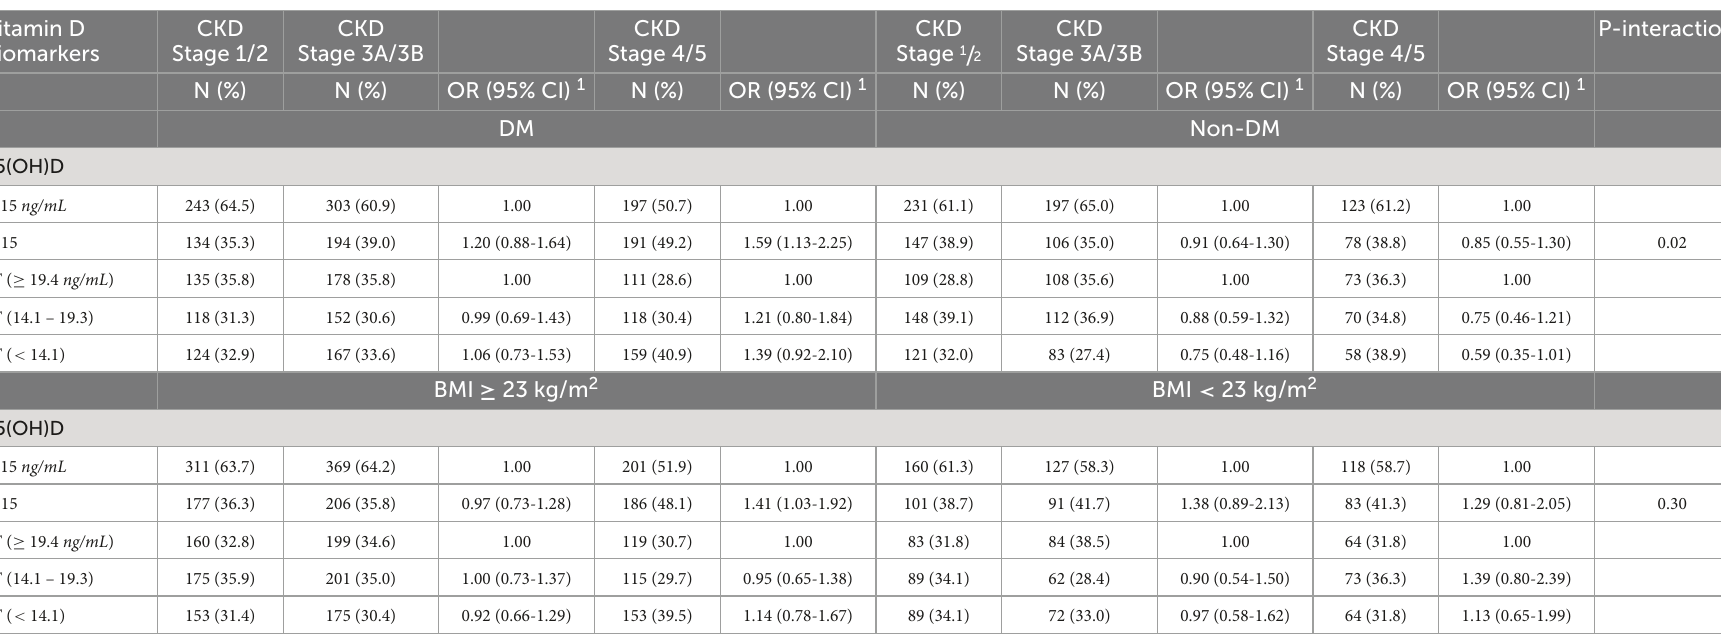
TABLE 3 Association between serum vitamin D levels and moderate (Stage 3A/3B) and severe CKD (Stage 4/5) stage according to diabetes and overweight status in the Korean Cohort Study for Outcome in Patients With Chronic Kidney Disease (KNOW-CKD) study, 2011-2015. Vitamin D